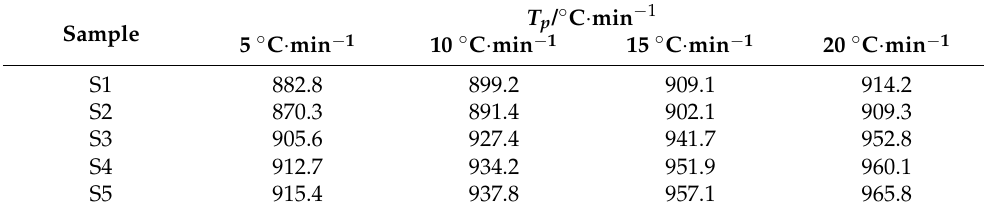
Table 4. T p of S1–S5 at different heating